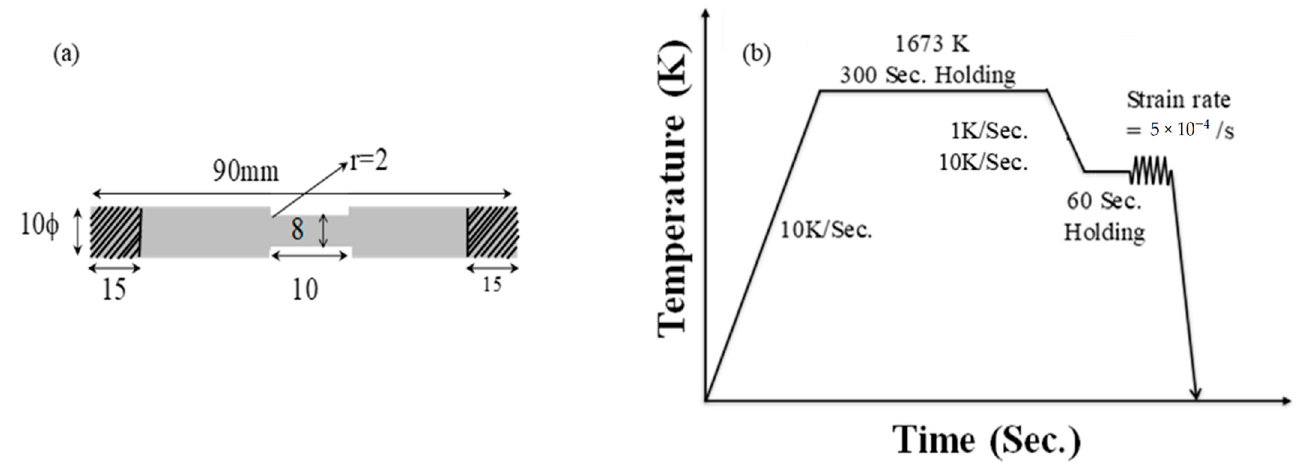
Figure 9. ( a ) Measurement of specimen, and ( b ) condition of tensile experiment.